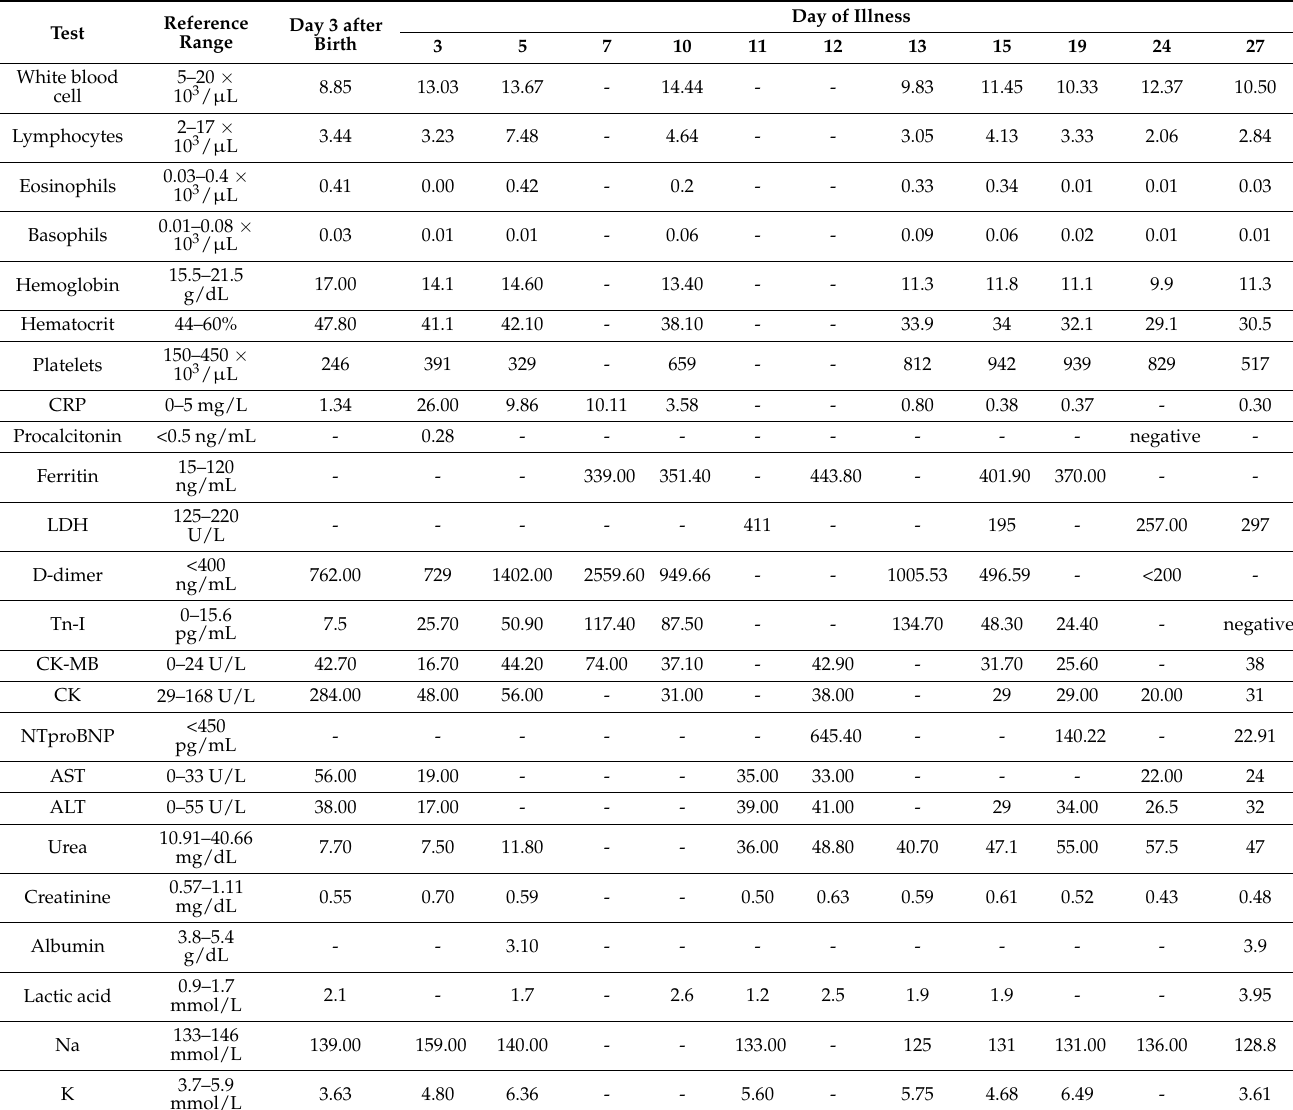
Table 1. Laboratory